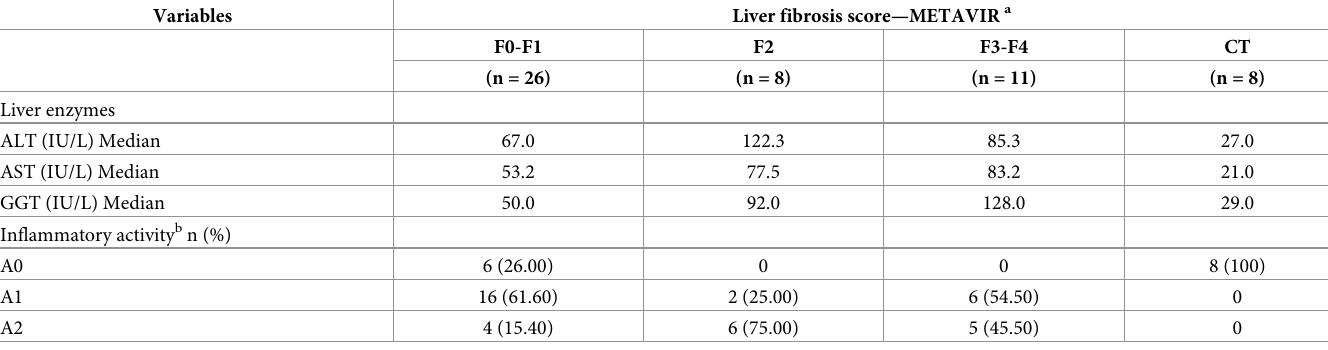
Table 2. Clinical, biochemical and histopathological data according to hepatic changes (METAVIR) in the study population.